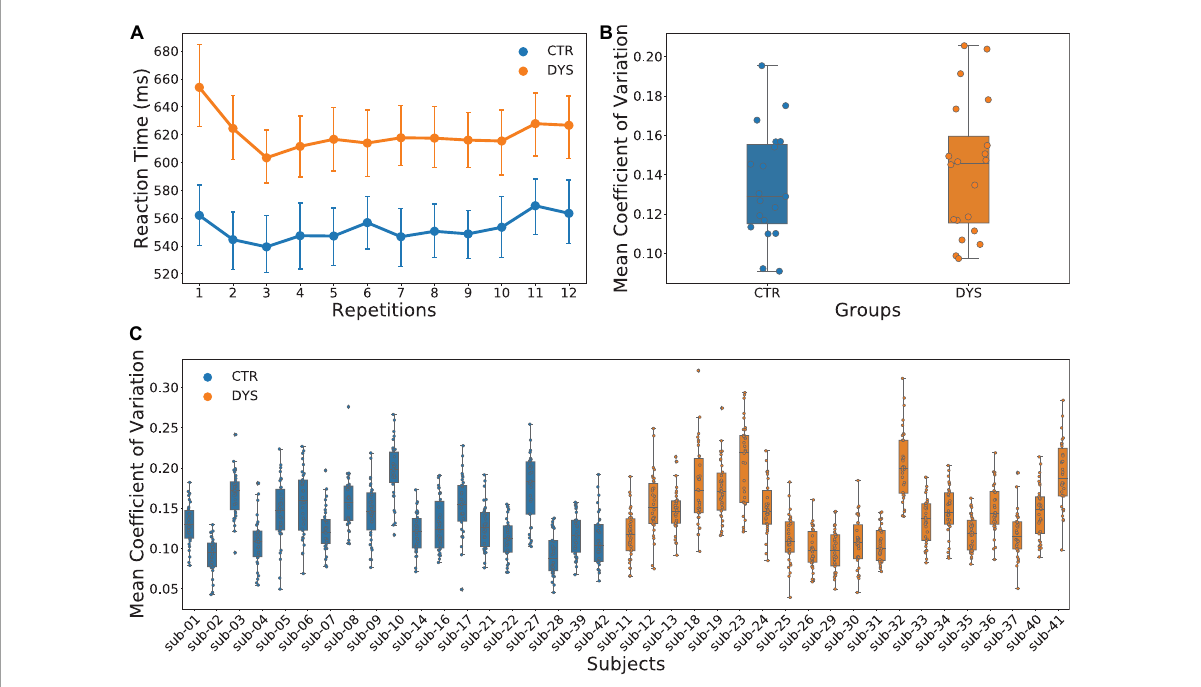
FIGURE3 Results of reading aloud latencies. (A) Mean reaction times (RTs) across the twelve repetitions for both typically developing (CTR) and dyslexic readers (DYS), (B) scattered box plots of mean coefficients of variation of RTs for both CTR and DYS, (C) scattered box plots of mean coefficients of variation of RTs calculated for each word across the 12 repetitions and for each participant.